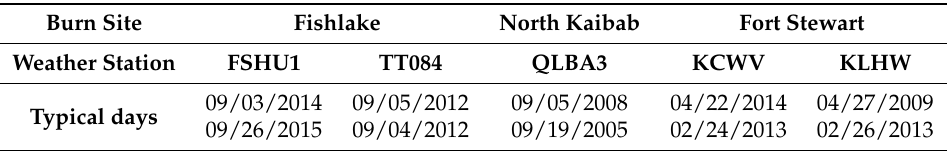
Table 3. Summary of most typical days identified for the burn